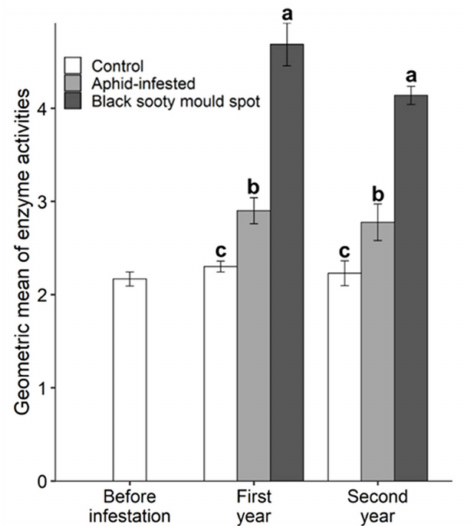
Figure 4. The e ff ect of T. salignus honeydew deposition on the geometric mean of soil enzyme activities, prior to aphid inoculation (before infestation), and after aphid inoculation (control, aphid-infested, and black sooty mould spots) in the first and second year. The values are the mean ± SE. Di ff erent letters represent statistically significant di ff erences between the treatments at each sampling time (Tukey’s HSD test, α =